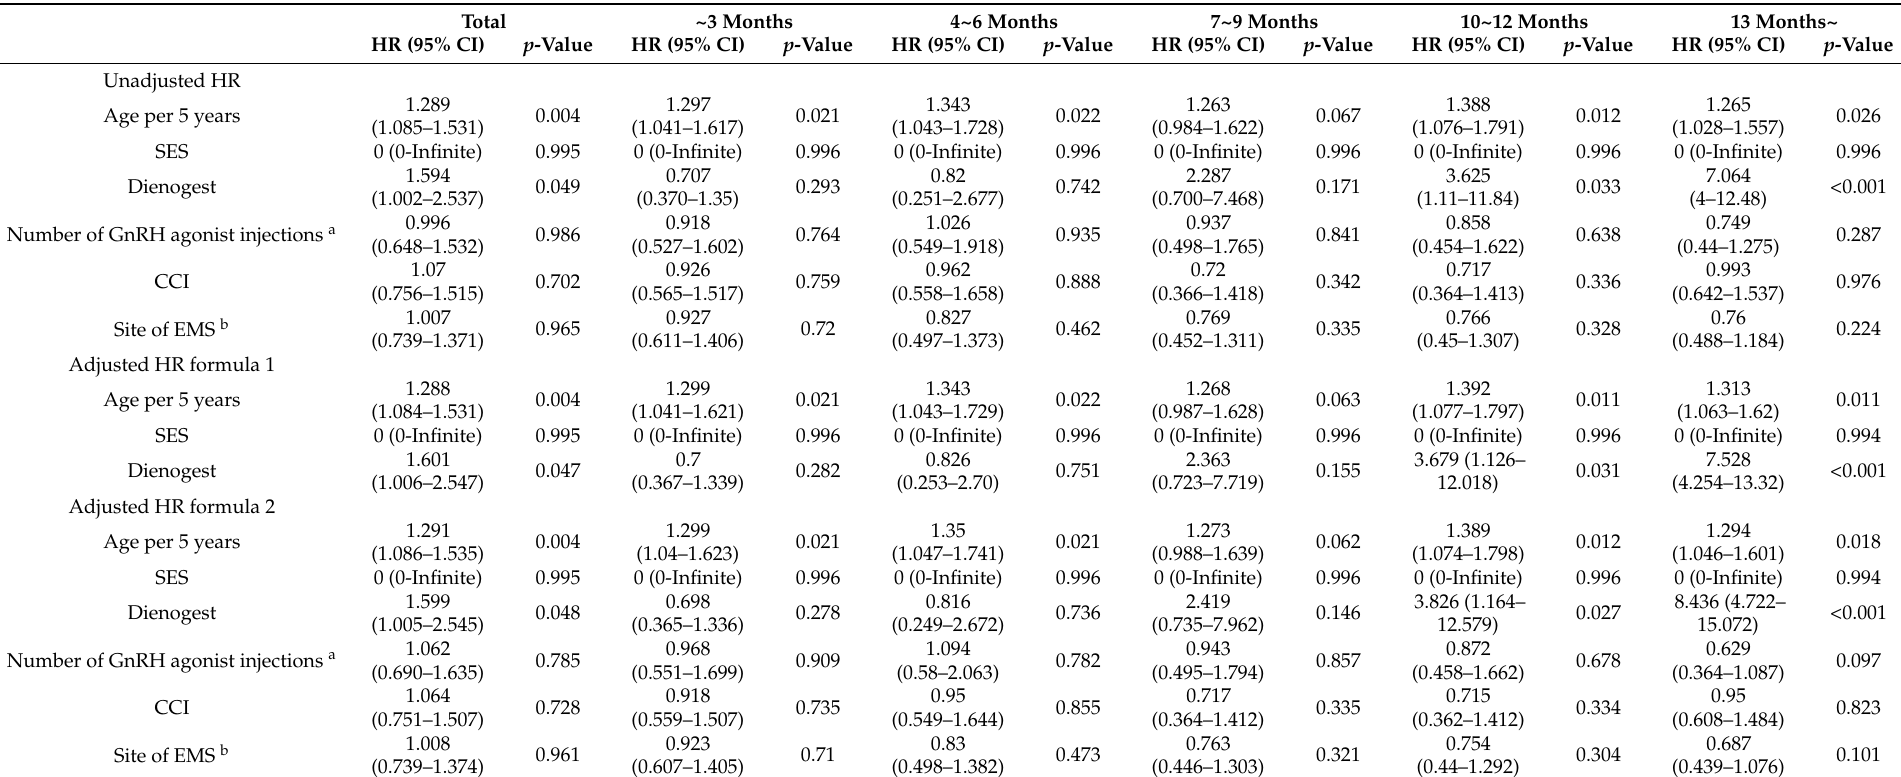
Table 4. Cox proportional hazard model for the reoperation rate according to dienogest initiation time in the HIRA 2013–2018